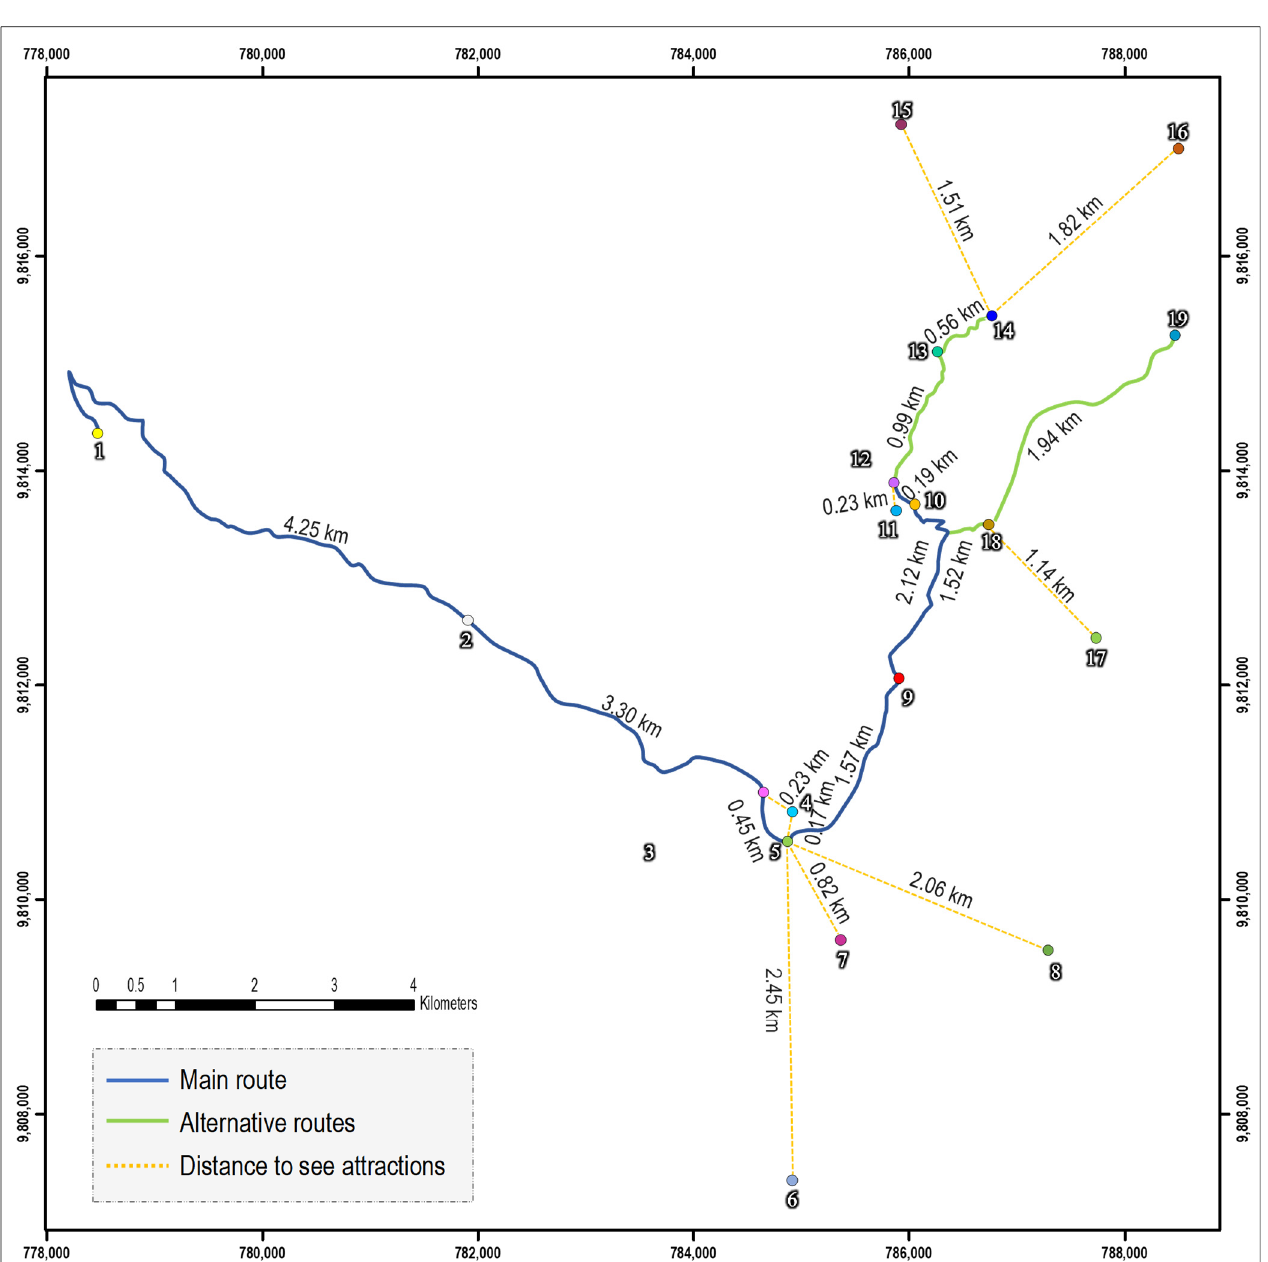
Figure 3. Network of tourist attractions identified by numbers in the study area. Legend: The study area is divided into the main route in blue color (numbers from 1 to 11); alternative 1 for trekking: points 12–16; and alternative 2 for high mountain route: points 17–19.